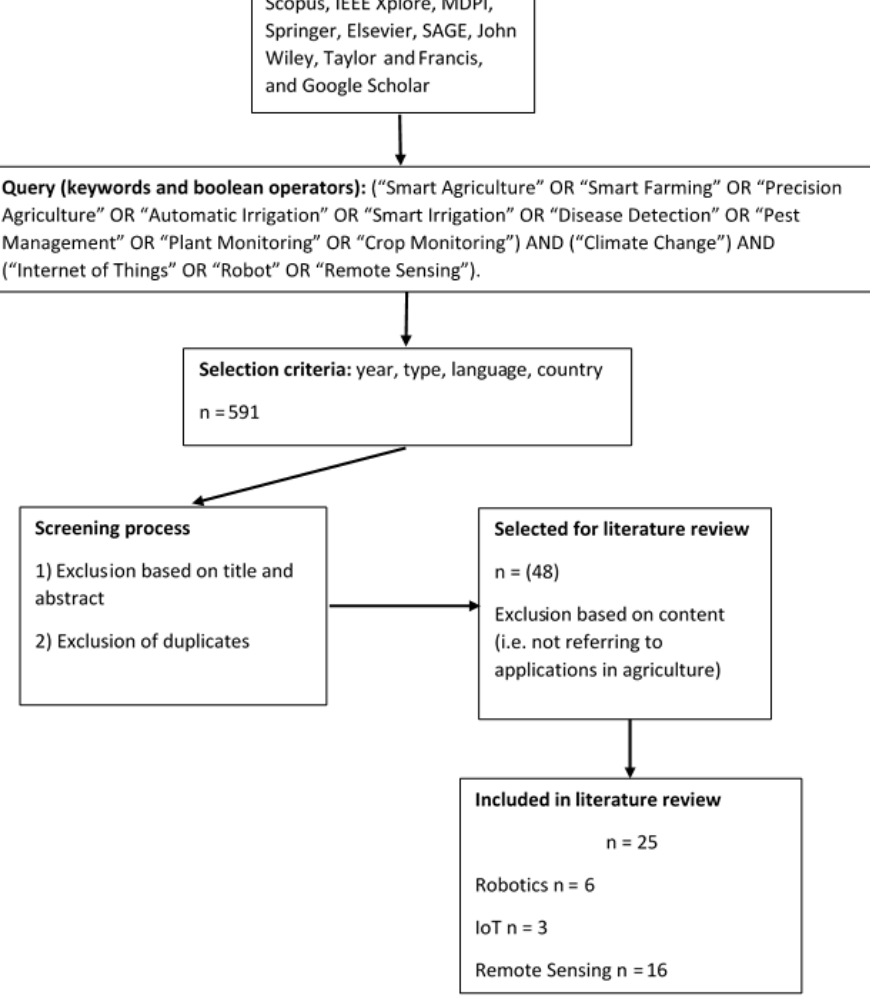
Figure 1. Flowchart of the literature search.